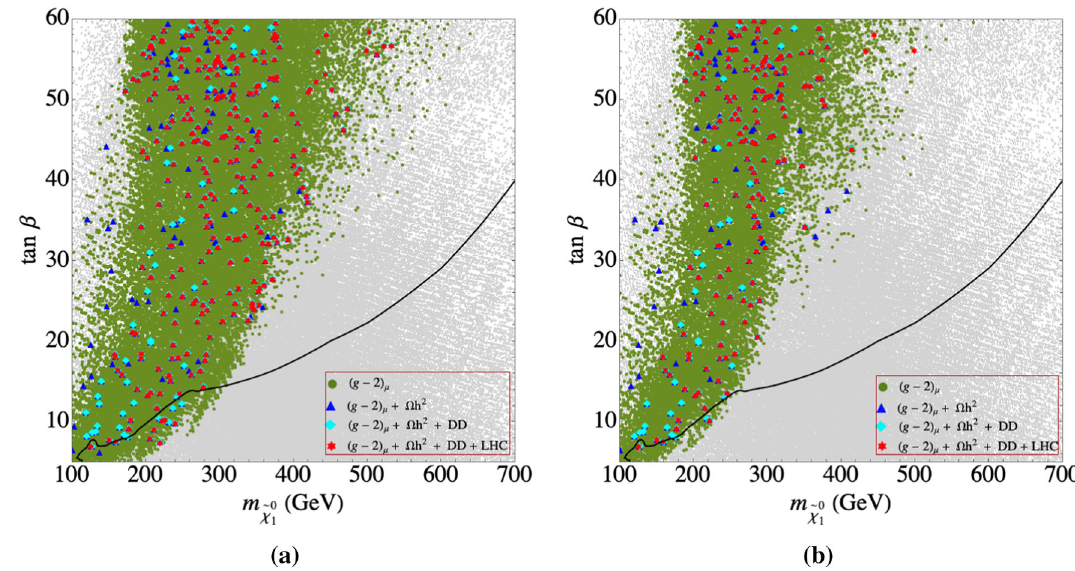
Fig. 10 The results of our parameter scan in the tan β − m ˜ χ 0 (right) from ( g − 2 ) μ ) . The color coding is as in Fig. 7